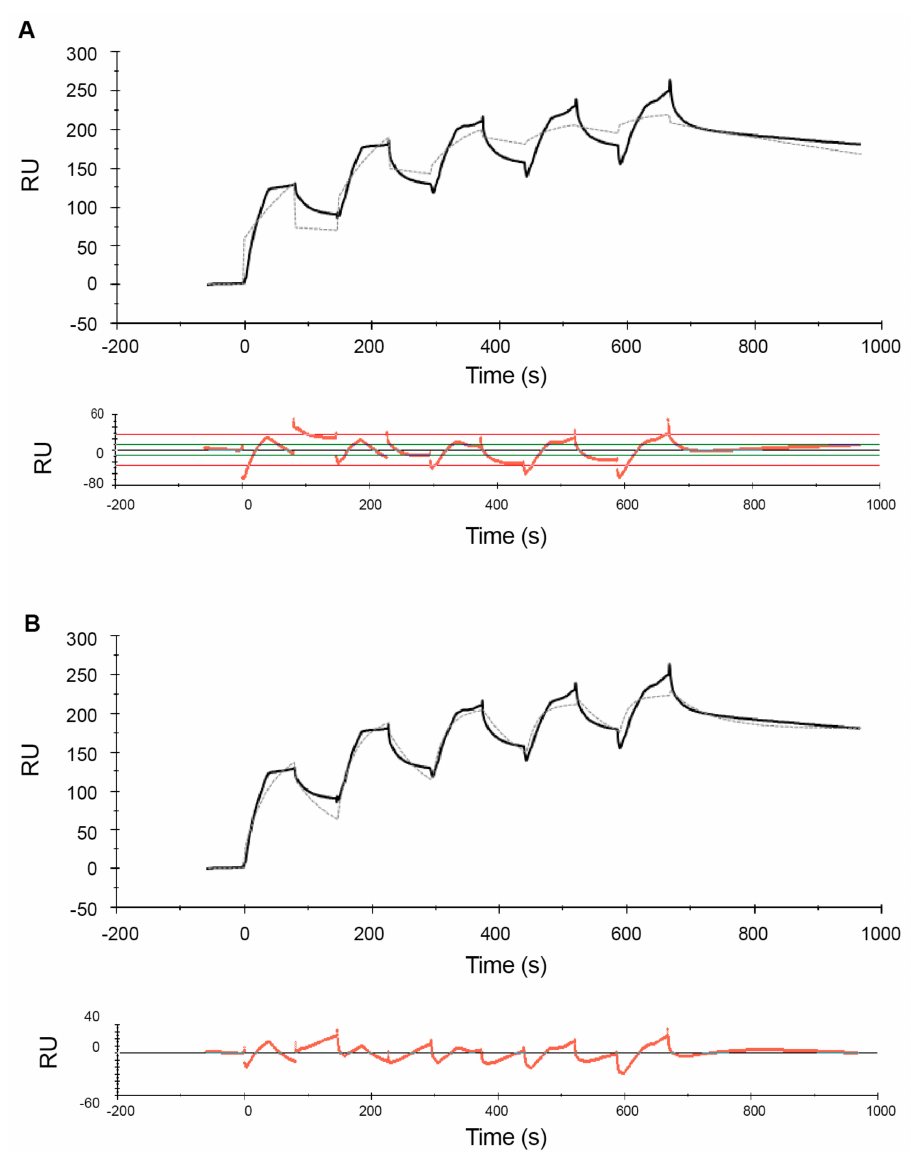
Figure 2. Sensorgrams of the melittin–POPC interaction using single-cycle kinetics for the mid-range concentrations. Following immobilization of POPC liposomes (1 mM lipid) to a binding response of ~4500 RU, increasing concentrations of melittin (0.3, 0.6, 0.9, 1.2 and 1.5 µ M) were serially injected in a single-cycle at a flow rate of 30 µ L / min for 80 s with a single regeneration step with 10 mM glycine–HCl (pH 2.5) at the end, i.e., after all five concentrations of melittin. Binding kinetic analysis of the sensorgrams with a Langmuir 1:1 model ( A ) and a two-state reaction model ( B ) were conducted using BIAevaluation ® software. The estimated rate constants and a ffi nity values, based on both these models, are listed in Tables 1 and